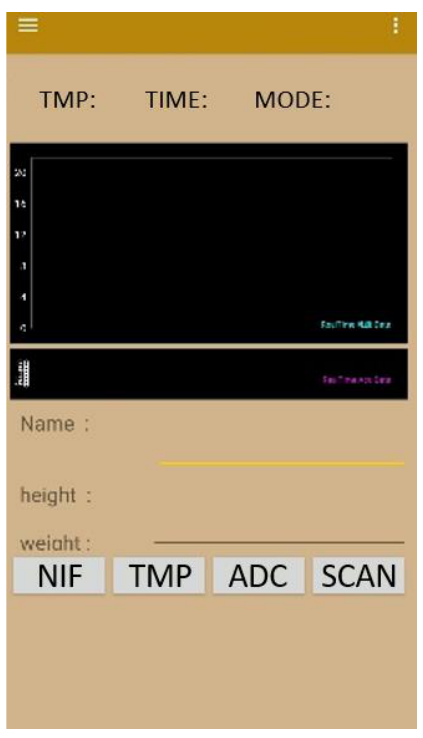
Figure 12. The interface of the Android mobile app for continuous lactate measurement.